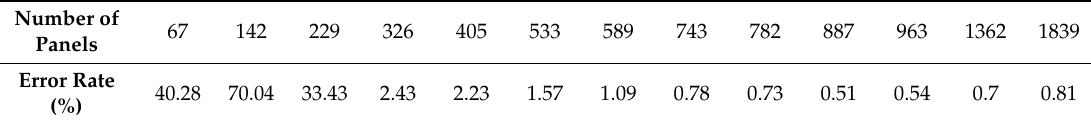
Table 1. The simulation error rate for the di ff erent panel quantities relative to the panel size of 4987 for the added pitch moment of inertia A 55